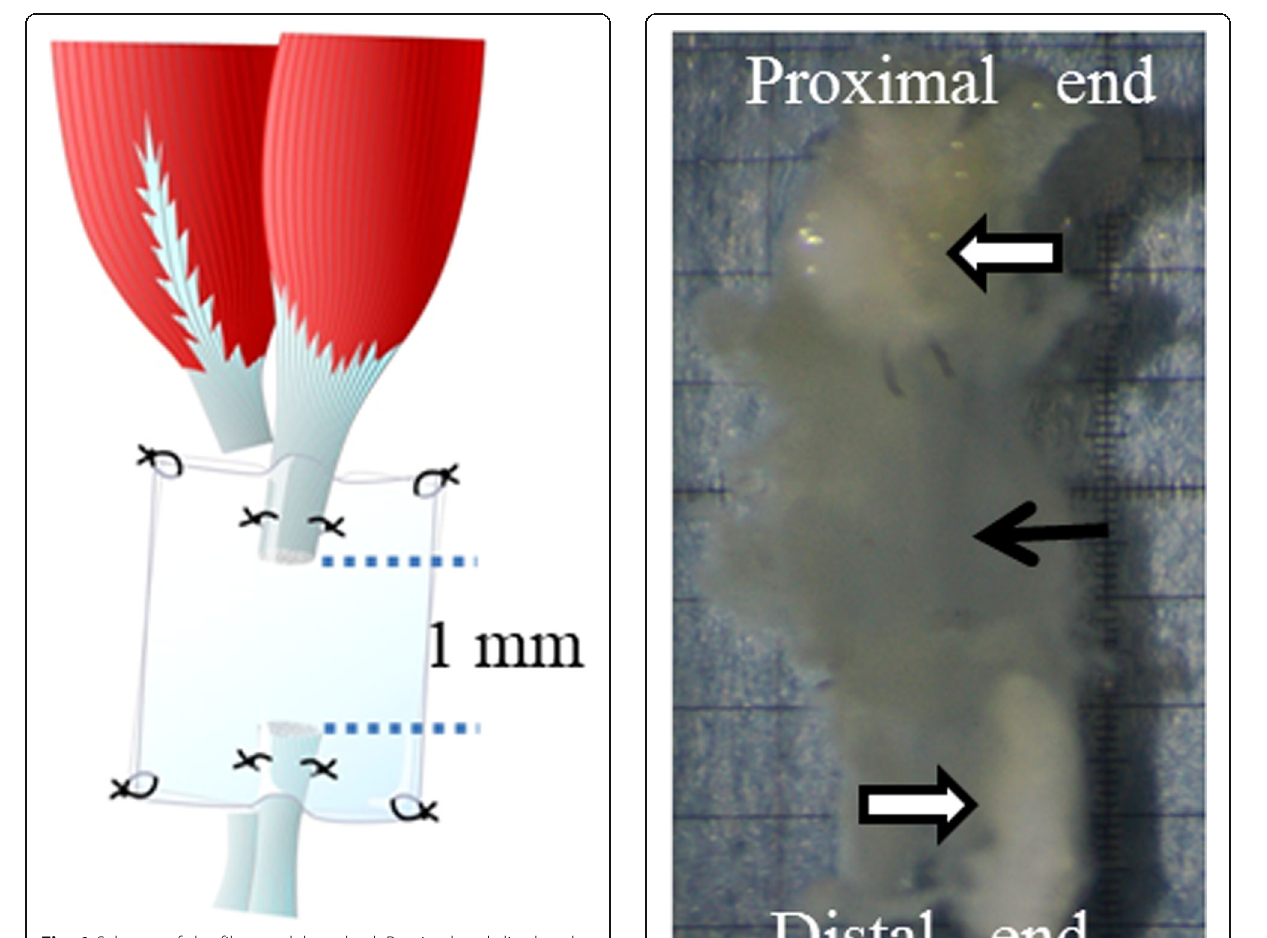
Fig. 1 Scheme of the film model method. Proximal and distal ends of the transected tendon are placed on a thin plastic film. The two cut ends face each other and are separated by approximately 1 mm